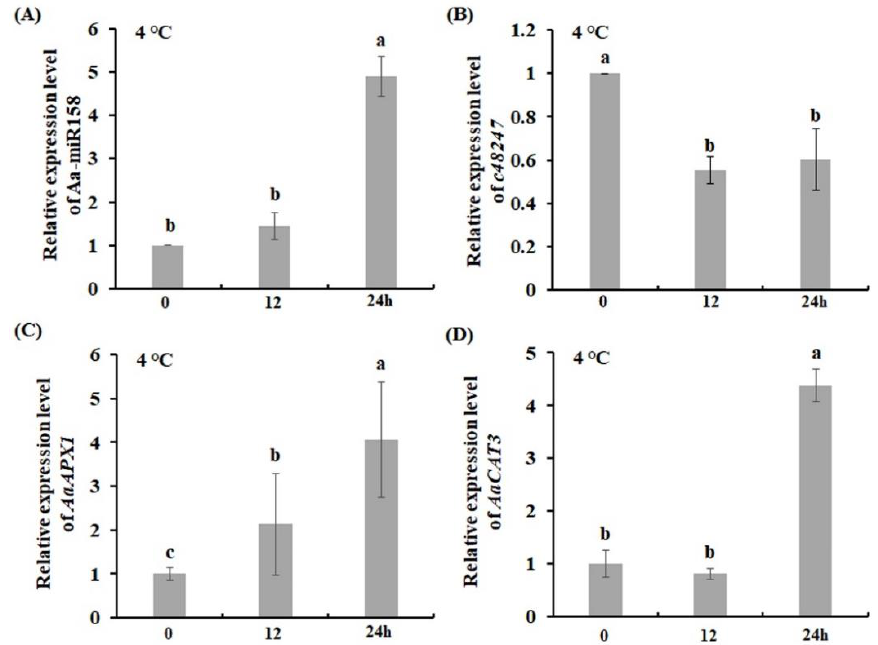
Figure 3. Expression analysis of Aa-miR158 ( A ), c48247 ( B ), AaAPX1 ( C ) and AaCAT3 ( D ) under cold stress. Seedlings of A. andraeanum were cultivated in MS medium and exposed to 4 °C treatment for 0, 12 or 24 h. Error bars represent standard deviations ( n = 3). Within each graph, values marked with the different letter are significantly different ( p < 0.05, Student ’ s t -test).